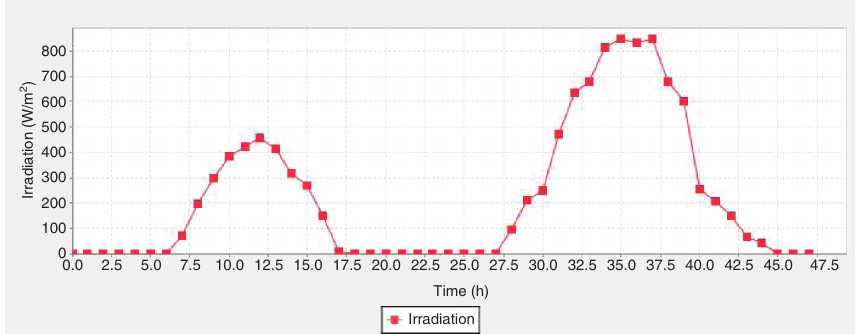
Figure 10: Profile of the Solar Irradiation.